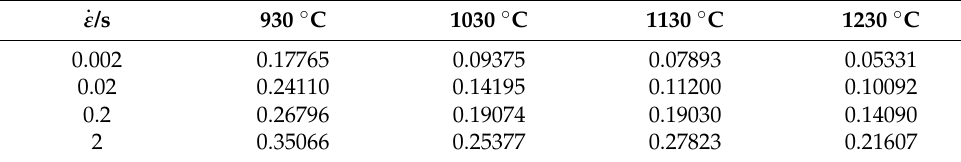
Table 2. Strain value corresponding to peak